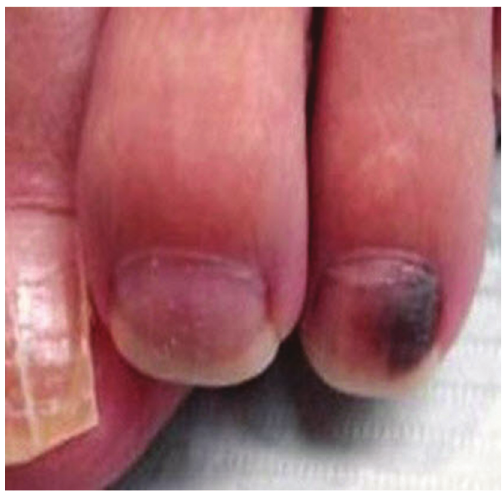
Figure 3: Subungual pigmentation.